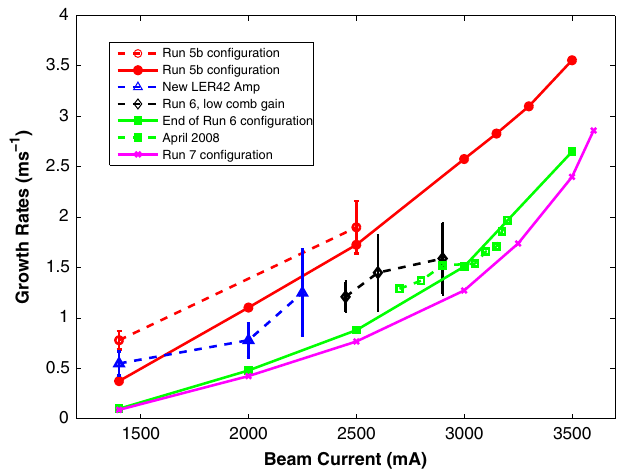
FIG. 16. (Color) Predicted (solid lines) and measured (dashed lines) growth rates. Improvements due to the upgrades are visible. Error bars are not included for the April 2008 data because they crowd the image. They are comparable in magni- tude with the error bars from the run 6